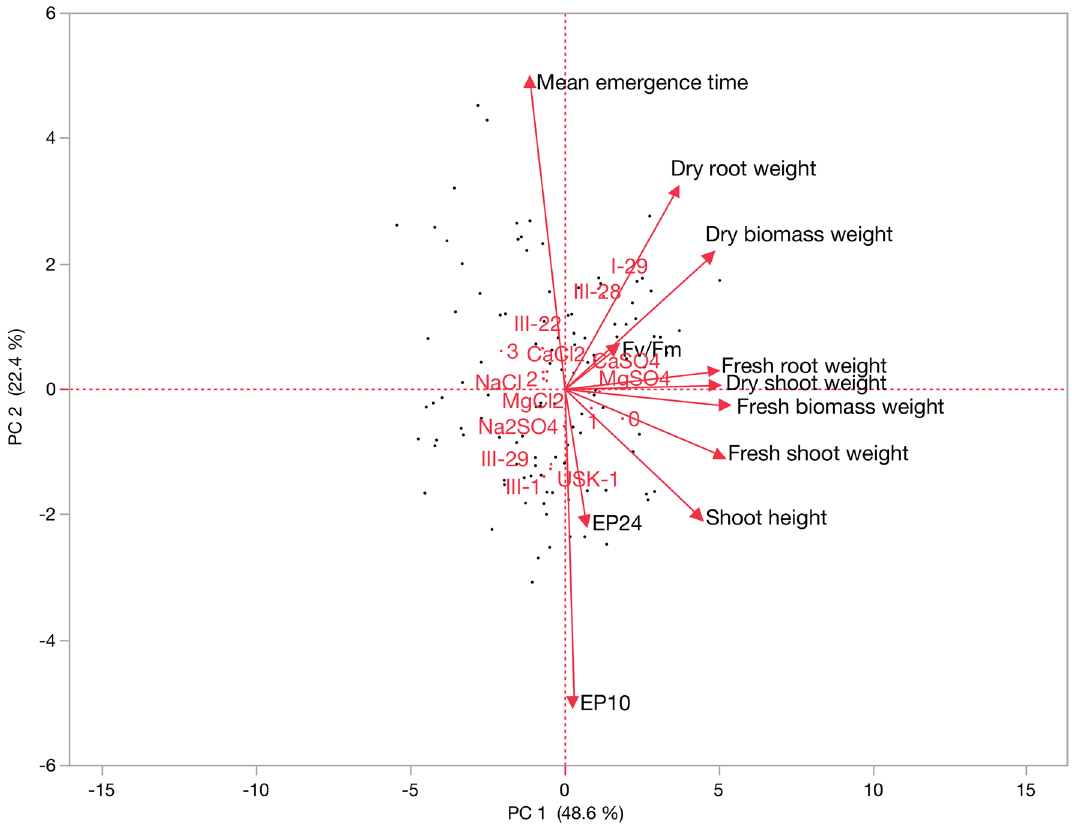
Figure 3. The principal component analysis (PCA) correlation of parameters with different salt sources and faba bean genotypes.